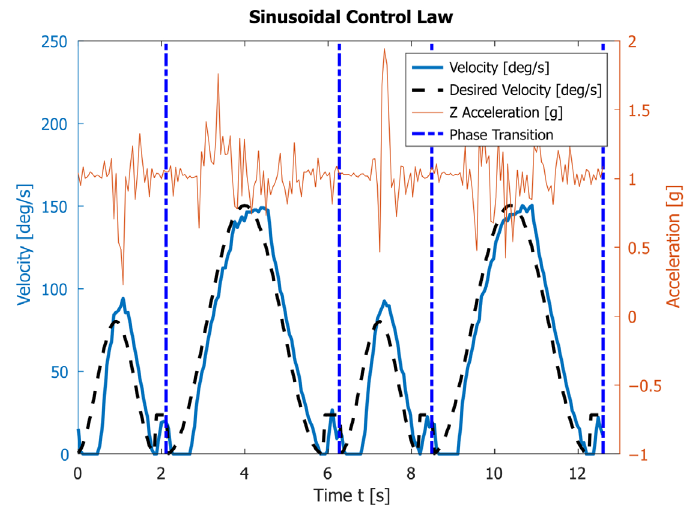
Figure 10. The angular velocity read by the encoder and the vertical acceleration obtained by the accelerometer during the motion of link 4 subjected to sinusoidal control law.